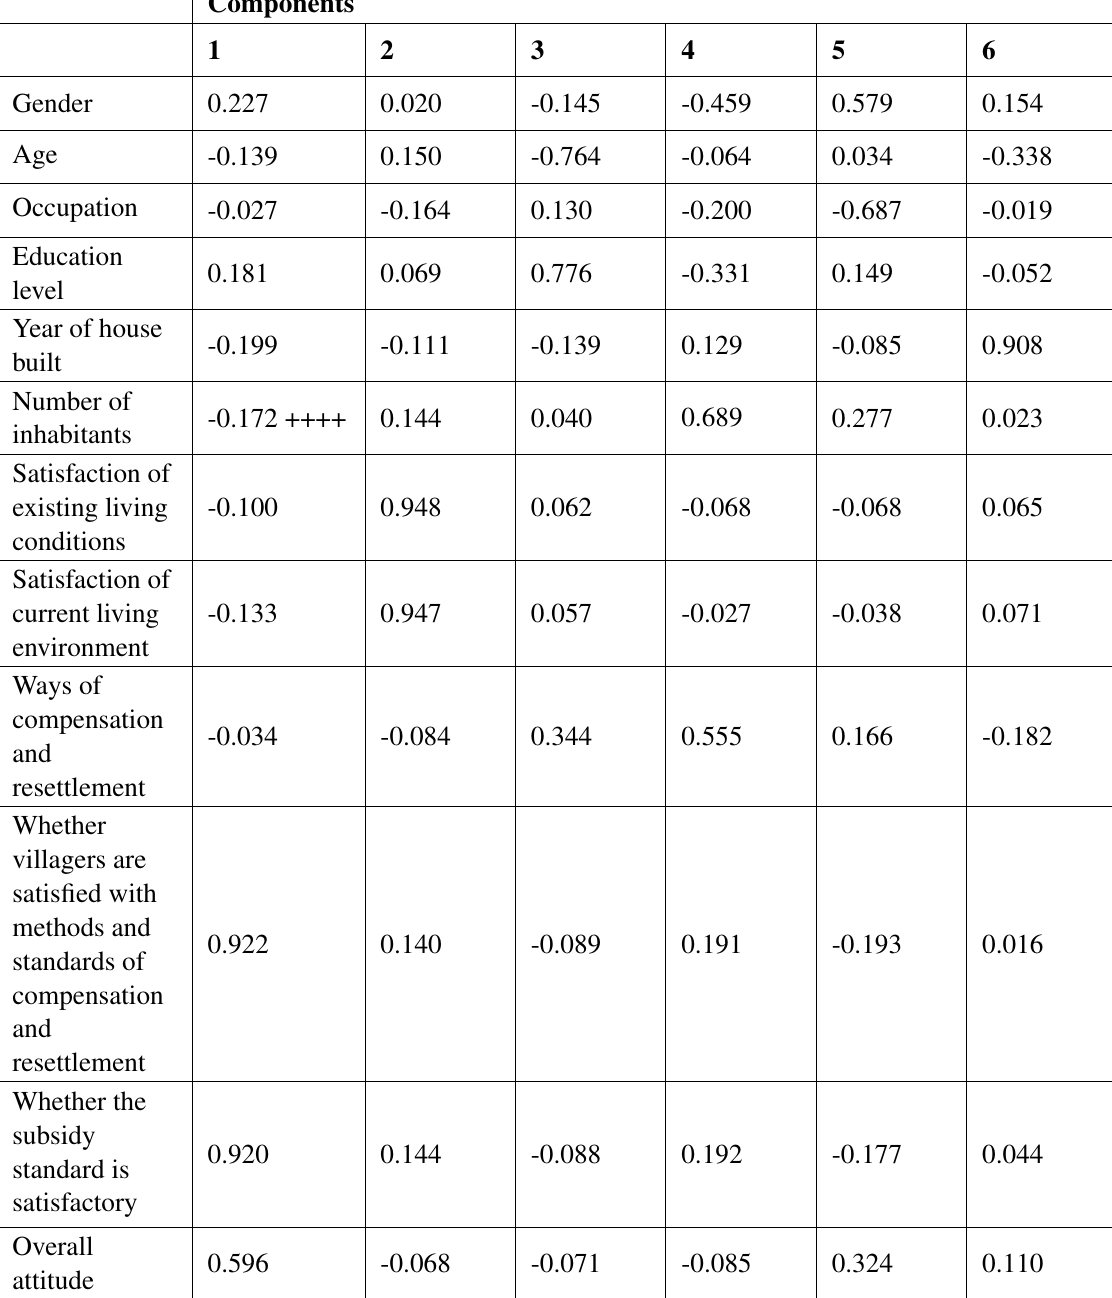
Table 5 Componential matrix a of related